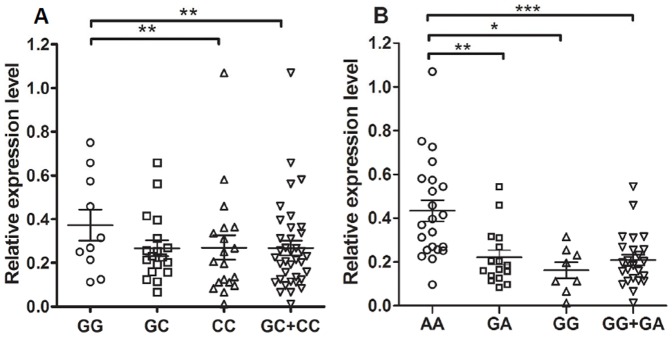
miR146a expression level with different genotypes of rs2910164 (A) and rs57095329 (B) in healthy individuals.The mature miR146a expression in PBMCS was analyzed in healthy individuals. The horizontal line indicates the mean expression level with each genotype groups. *p<0.05; **p<0.01; ***p<0.001.